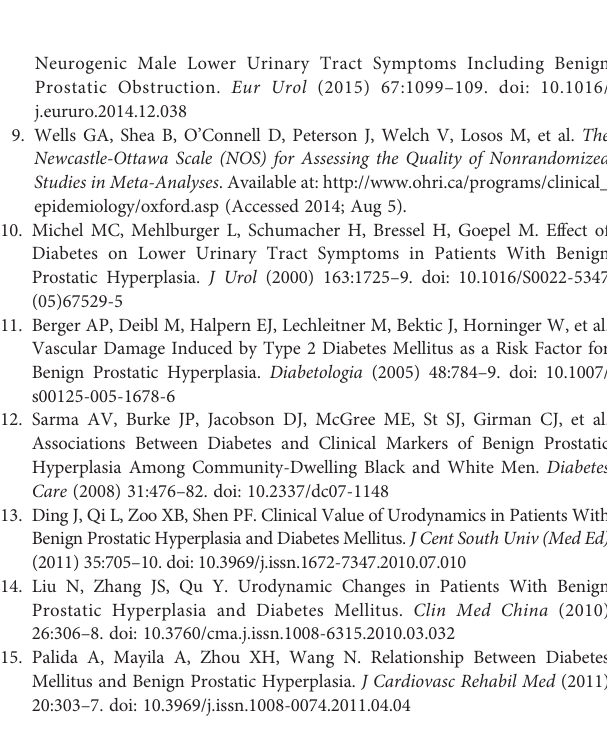
Supplementary Figure S1 | The sensitivity analysis results of International Prostate Symptom Score comparing diabetes group to without diabetes group in benign prostatic hyperplasia patients. Supplementary Figure S3 | The sensitivity analysis results of maximal fl ow rate comparing diabetes group to without diabetes group in benign prostatic hyperplasia patients. Supplementary Figure S4 | The sensitivity analysis results of prostate-speci fi c antigen value comparing diabetes group to without diabetes group in benign prostatic hyperplasia patients. Supplementary Figure S5 | The funnel plot of International Prostate Symptom Score comparing diabetes group to without diabetes group in benign prostatic hyperplasia patients. Supplementary Figure S6 | The funnel plot of prostate volume comparing diabetes group to without diabetes group in benign prostatic hyperplasia patients. Supplementary Figure S7 | The funnel plot of maximal fl ow rate comparing diabetes group to without diabetes group in benign prostatic hyperplasia patients. Supplementary Figure S8 | The funnel plot results of prostate-speci fi c antigen value comparing diabetes group to without diabetes group in benign prostatic hyperplasia